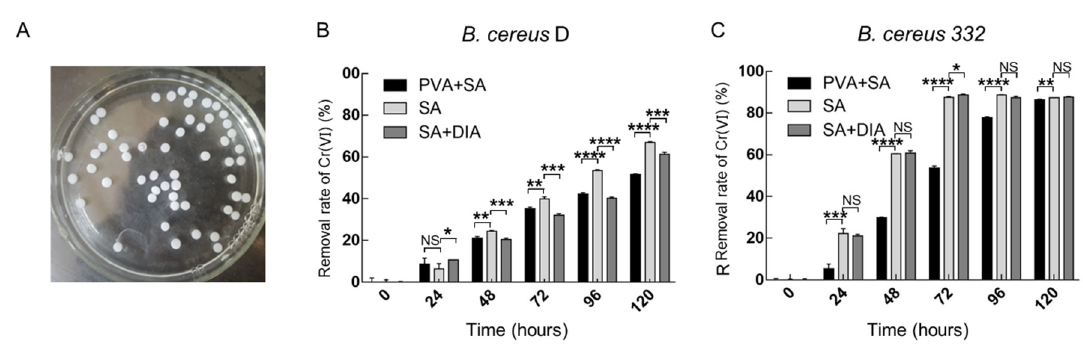
Figure 8. The morphology of immobilized cells ( A ). The Cr(VI) reduction in immobilized B. cereus D ( B ) and immobilized B. cereus 332 ( C ) with an initial 2 mM Cr(VI) concentration at 37 ◦ C, pH = 7.0. PVA indicates polyvinyl alcohol, SA indicates sodium alginate, DIA indicates diatomite. **** indicates p < 0.0001, *** indicates p < 0.001, ** indicates p < 0.01, * indicates p < 0.05, NS indicates no significant difference.